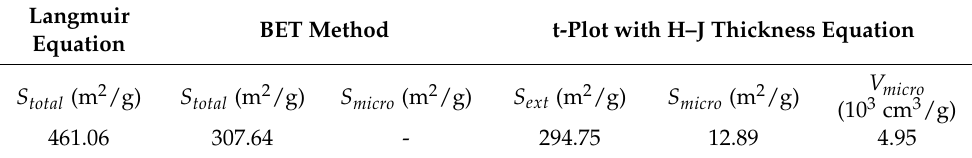
Figure 4. BET adsorption isotherm and H–J t-plot (inside) of N 2 at 77 K for the produced silica sample. Table 1. Pore structure parameters were obtained using the BET, Langmuir, and t-plot